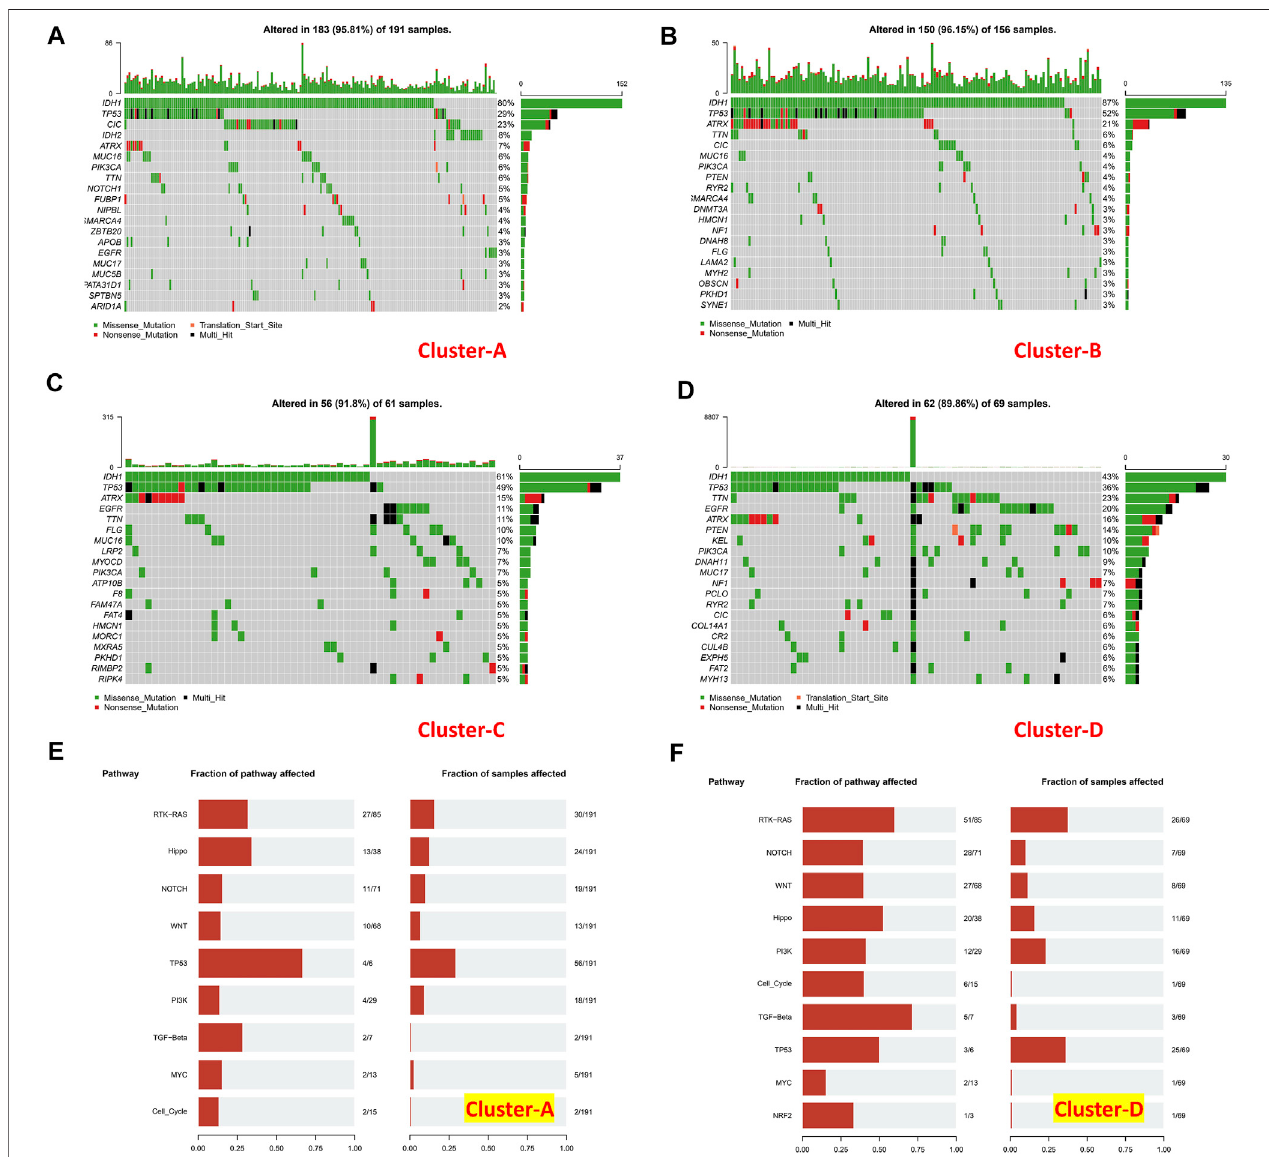
FIGURE10| Mutationlandscapesofimmuneclusters. (A) Gene mutation landscape inclusterA, (B) clusterB, (C) cluster C,and (D) cluster D .Pathwaysaffected in (E) cluster A and (F) cluster (D)